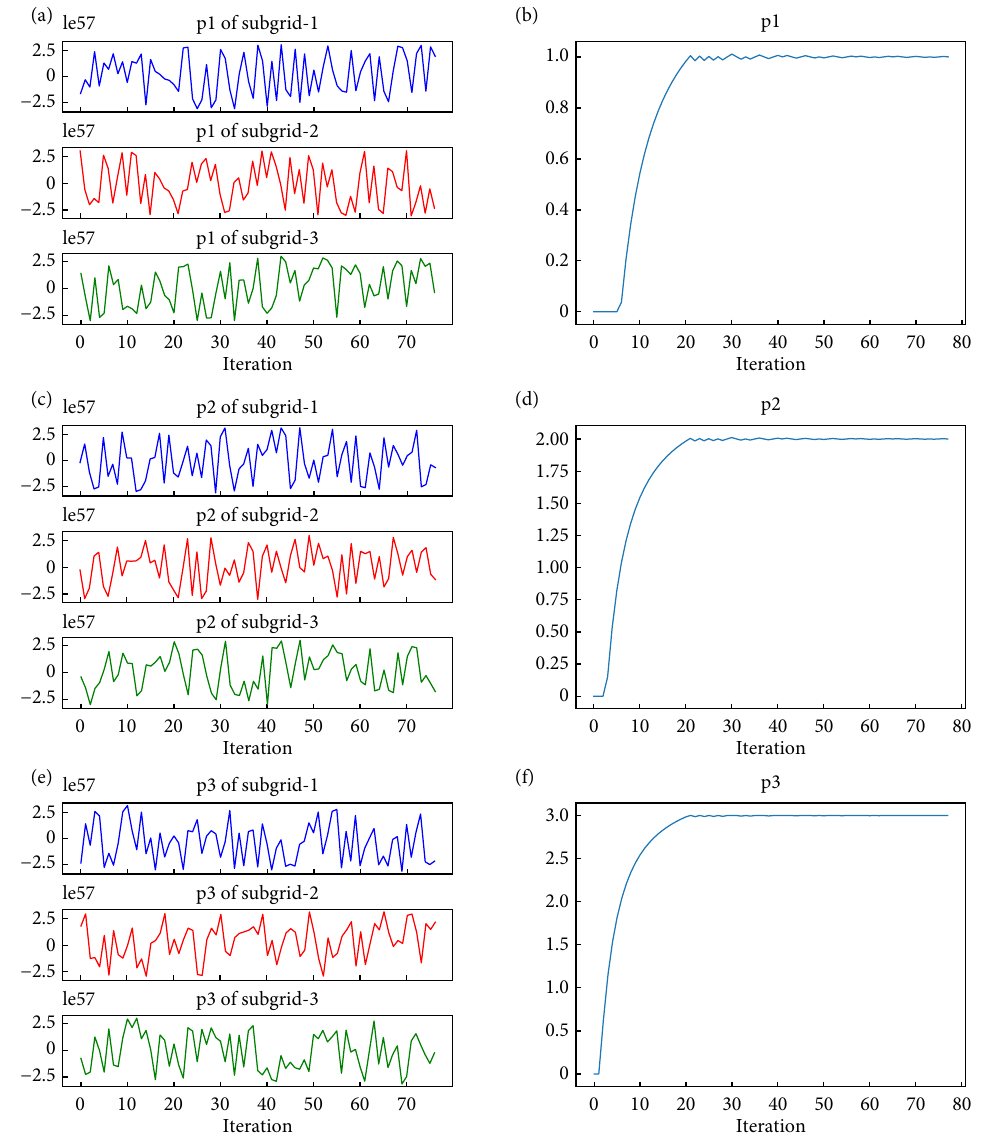
Fig. 10 The convergence performance of the unit output: (a, c, and e) show the secret sharing value of unit output p of each subgrid, and (b, d, and f) show the real value of p of each